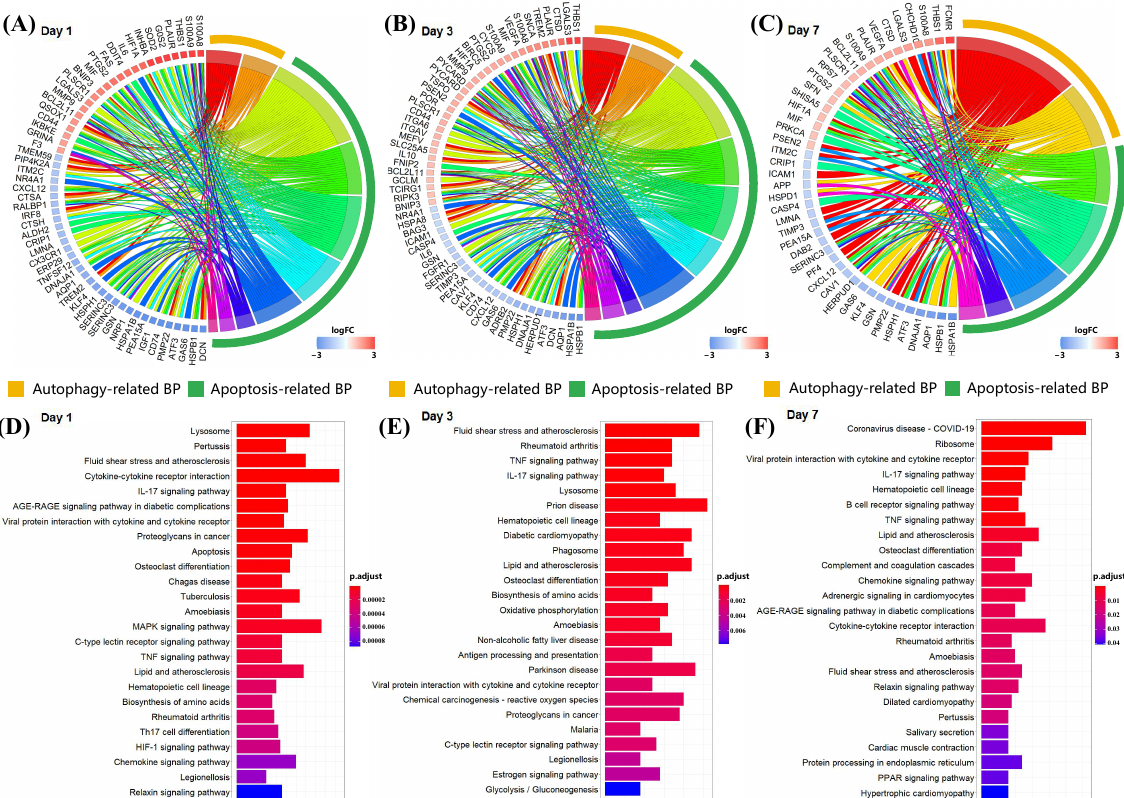
Figure 4. Enrichment analysis of DEGs at each time point in scRNA-seq data. ( A ) Circle diagram of the biological process analysis of significant DEGs on day 1 post-MI and ( B ) for day 3 post-MI, ( C ) for day 7 post-MI. Different colored blocks represent different biological processes. The yellow band in the outermost circle indicates autophagy-related BPs, and the green band indicates apoptosis-related BPs. ( D ) Bar chart of the KEGG analysis of significant DEGs on day 1 post-MI and ( E ) for day 3 post-MI, ( F ) for day 7 post-MI. Only the first 25 pathways are shown in the figure, and the p cut-off value of all pathways is